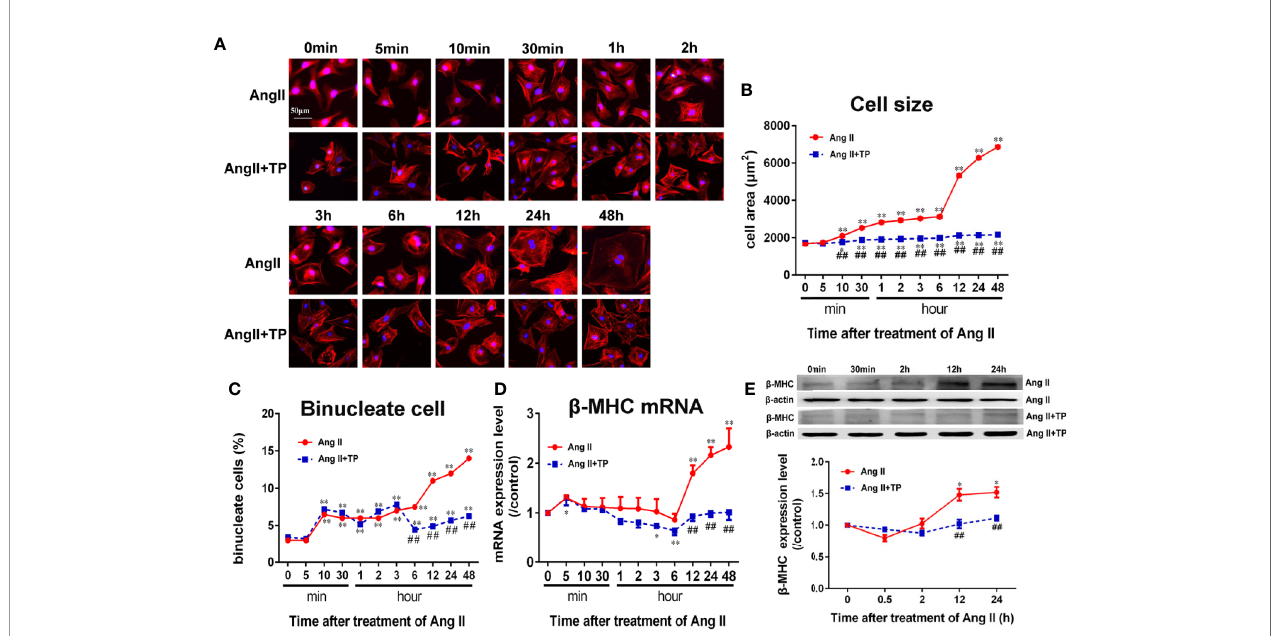
FIGURE 2 | Triptolide attenuated the hypertrophic response of neonatal rat ventricular myocytes. (A) NRVMs treated with Ang II (1.0 µmol/L) and 1.0 m g/L TP for the scheduled times and stained with rhodamine-phalloidin (bar = 50 µm). (B) Cell size ( n = 50 cells in each group). (C) Binucleate cell percentage (n = 6 analysis and 150 cells for each analysis). (D) mRNA expression of b -MHC was determined using real-time PCR ( n = 6). (E) b -MHC protein expression was determined using Western blotting ( n = 4). The data are presented as the mean ± SEM, *P < 0.05, **P < 0.01 compared with the controls (0 min), ## P < 0.01 compared with the Ang II-treated group at the same time point (one-way